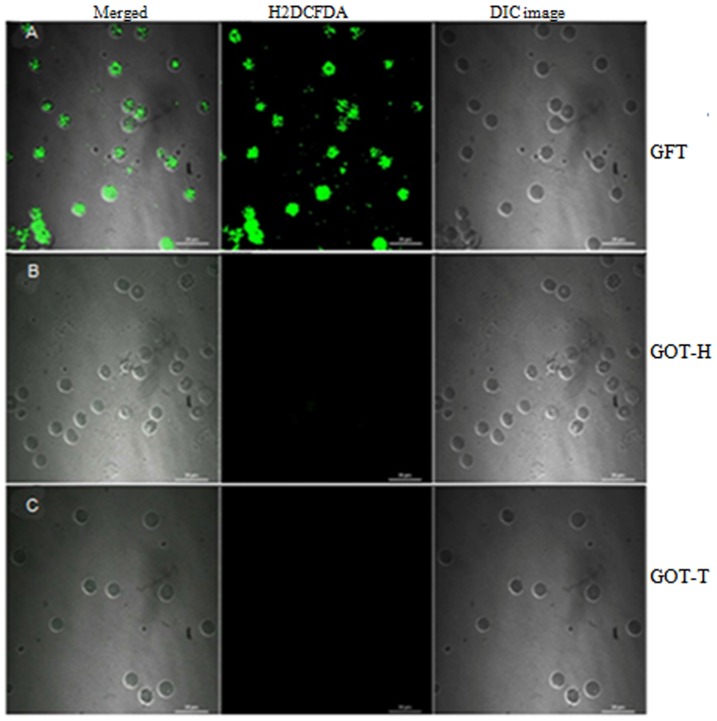
Detection of ROS generation by dichlorofluorescein assay.The representative confocal images demonstrate higher level of ROS production in the GFT ovarian granulosa cells (Fig. 9A), but the cells isolated from the host (GOT-H) ovary (Fig. 9B), like those of the transplanted ovary (GOT-T) (Fig. 9C), demonstrate little or no ROS positive cells. Each image is one representative of 7–9 replicates, 2–3 replicates from independent granulosa cell pool, and each pool represented by ovaries from 6–8 rats.